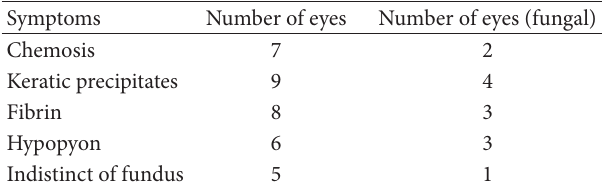
Table 2: Clinical